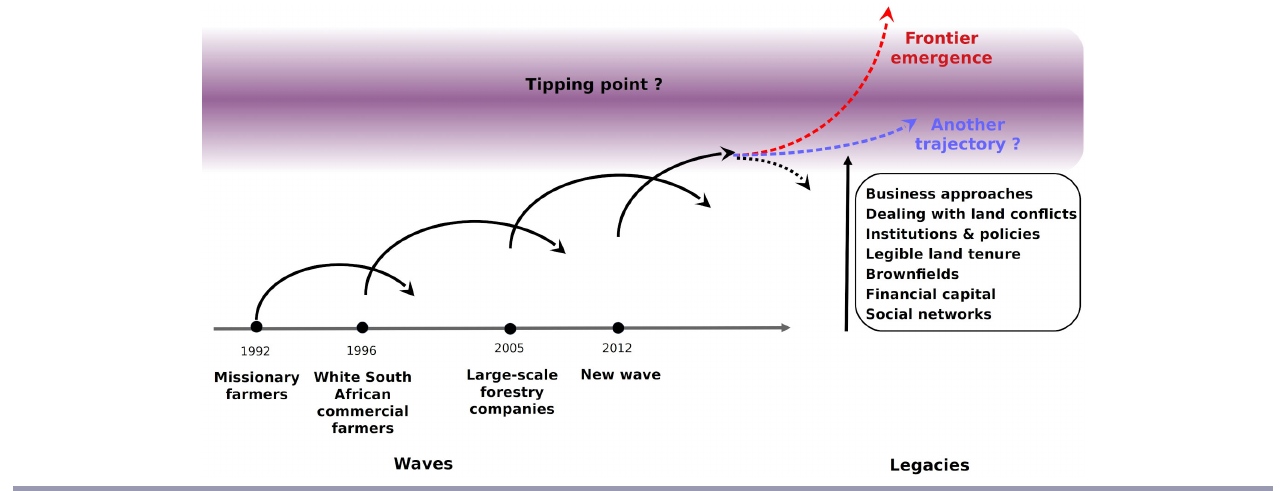
Fig. 3 . Waves, legacies, and frontier emergence in